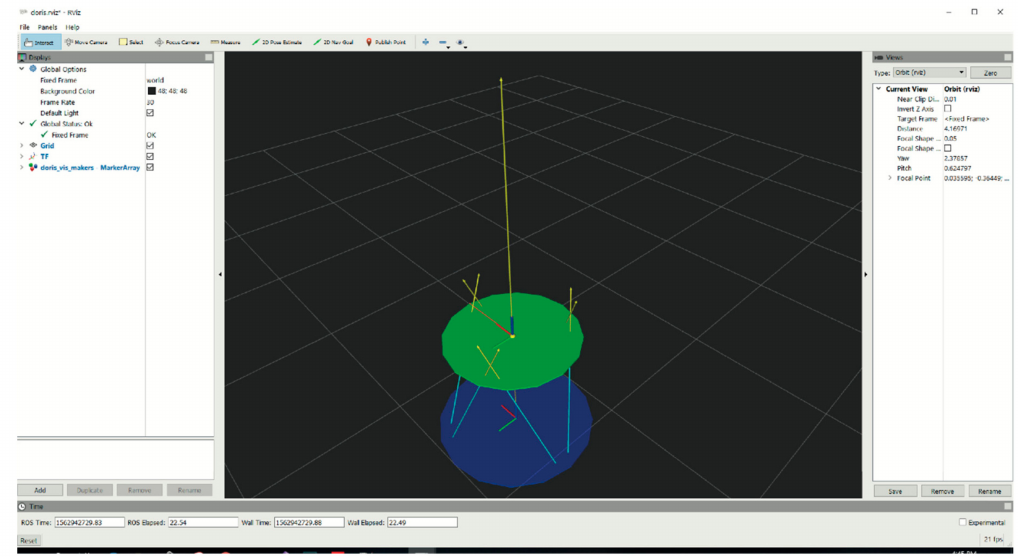
Figure 4. The Graphical User Interface (GUI) implemented with the ROS RVIZ interface. At all times, the state of the Stewart platform, with its reaction forces and the center of pressure (COP), can be visualized and monitored on this